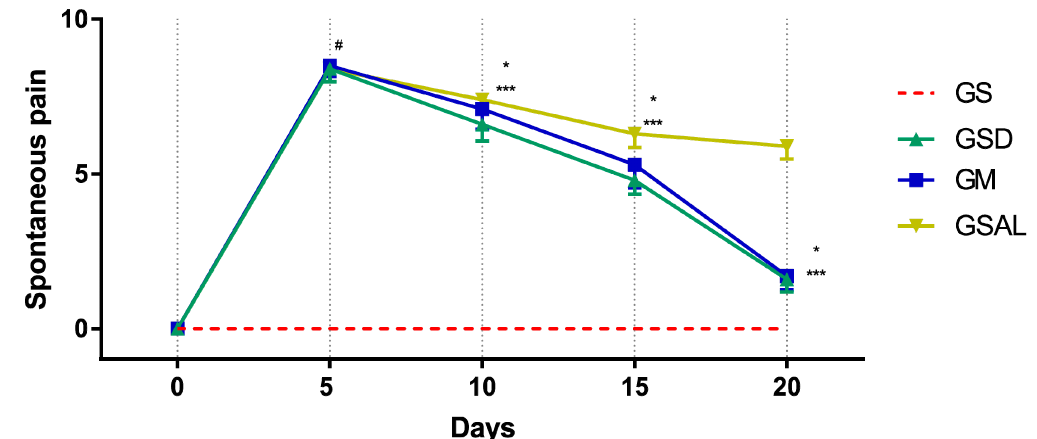
Figure 5. Effect of crude extract of S. dulcis on the evaluation of spontaneous pain by Mouse Grimace Scale. Results were expressed as mean ± standard mean error; # difference between GS and GSAL in D5 ( p ˂ 0.0001), GS and GSD in D5 ( p ˂ 0.0001), GS and GM in D5 ( p ˂ 0.0001); * difference between GSD and GSAL in D10 ( p = 0.0062), D15 ( p ˂ 0.0001) and D20 ( p ˂ 0.0001); *** difference between GM and GSAL in D10 ( p = 0.0068), D15 ( p = 0.0003) and D20 ( p ˂ 0.0001), using 2-way ANOVA with the multiple comparisons test ( p < 0.05).